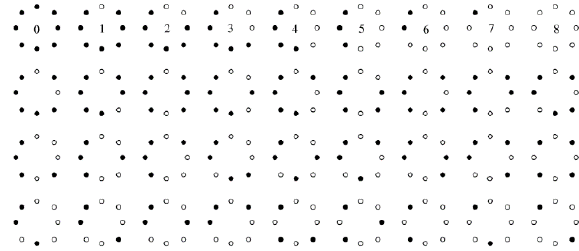
Figure 2. The 36 possible rotation invariant binary patterns (Ojala, et al., 2002)